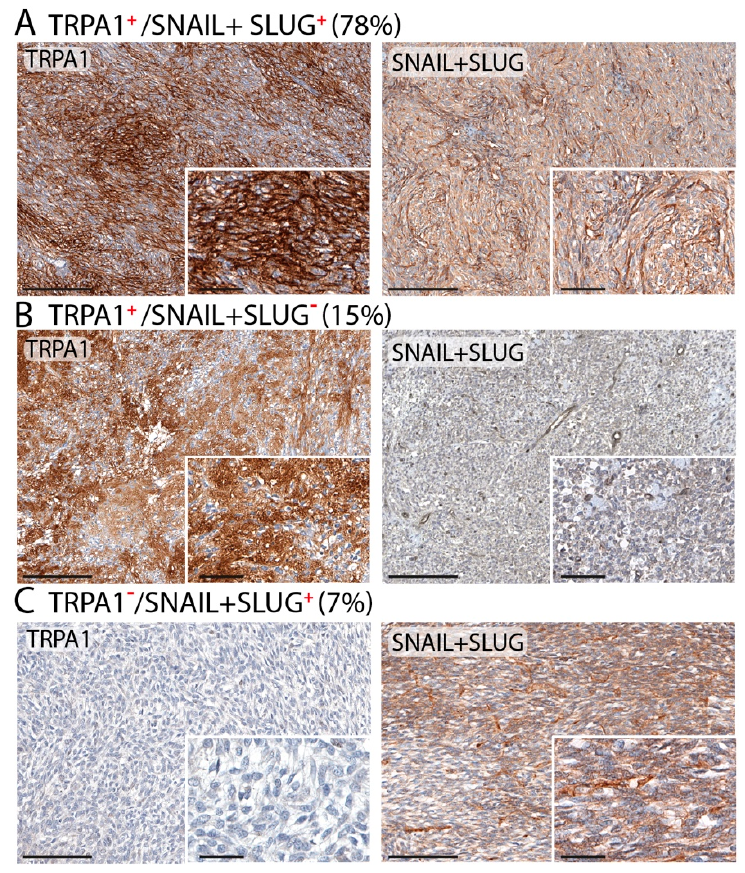
Figure 4. Representative photomicrographs and percentage of SS samples with TRPA1 staining positive with SNAIL + SLUG ( A ), and negative with SNAIL + SLUG ( B ); and negative with TRPA1 and positive with SNAIL + SLUG staining ( C ). Magnification × 200, inset × 400 (Scale bars: 100 µ m, inset 20 µ